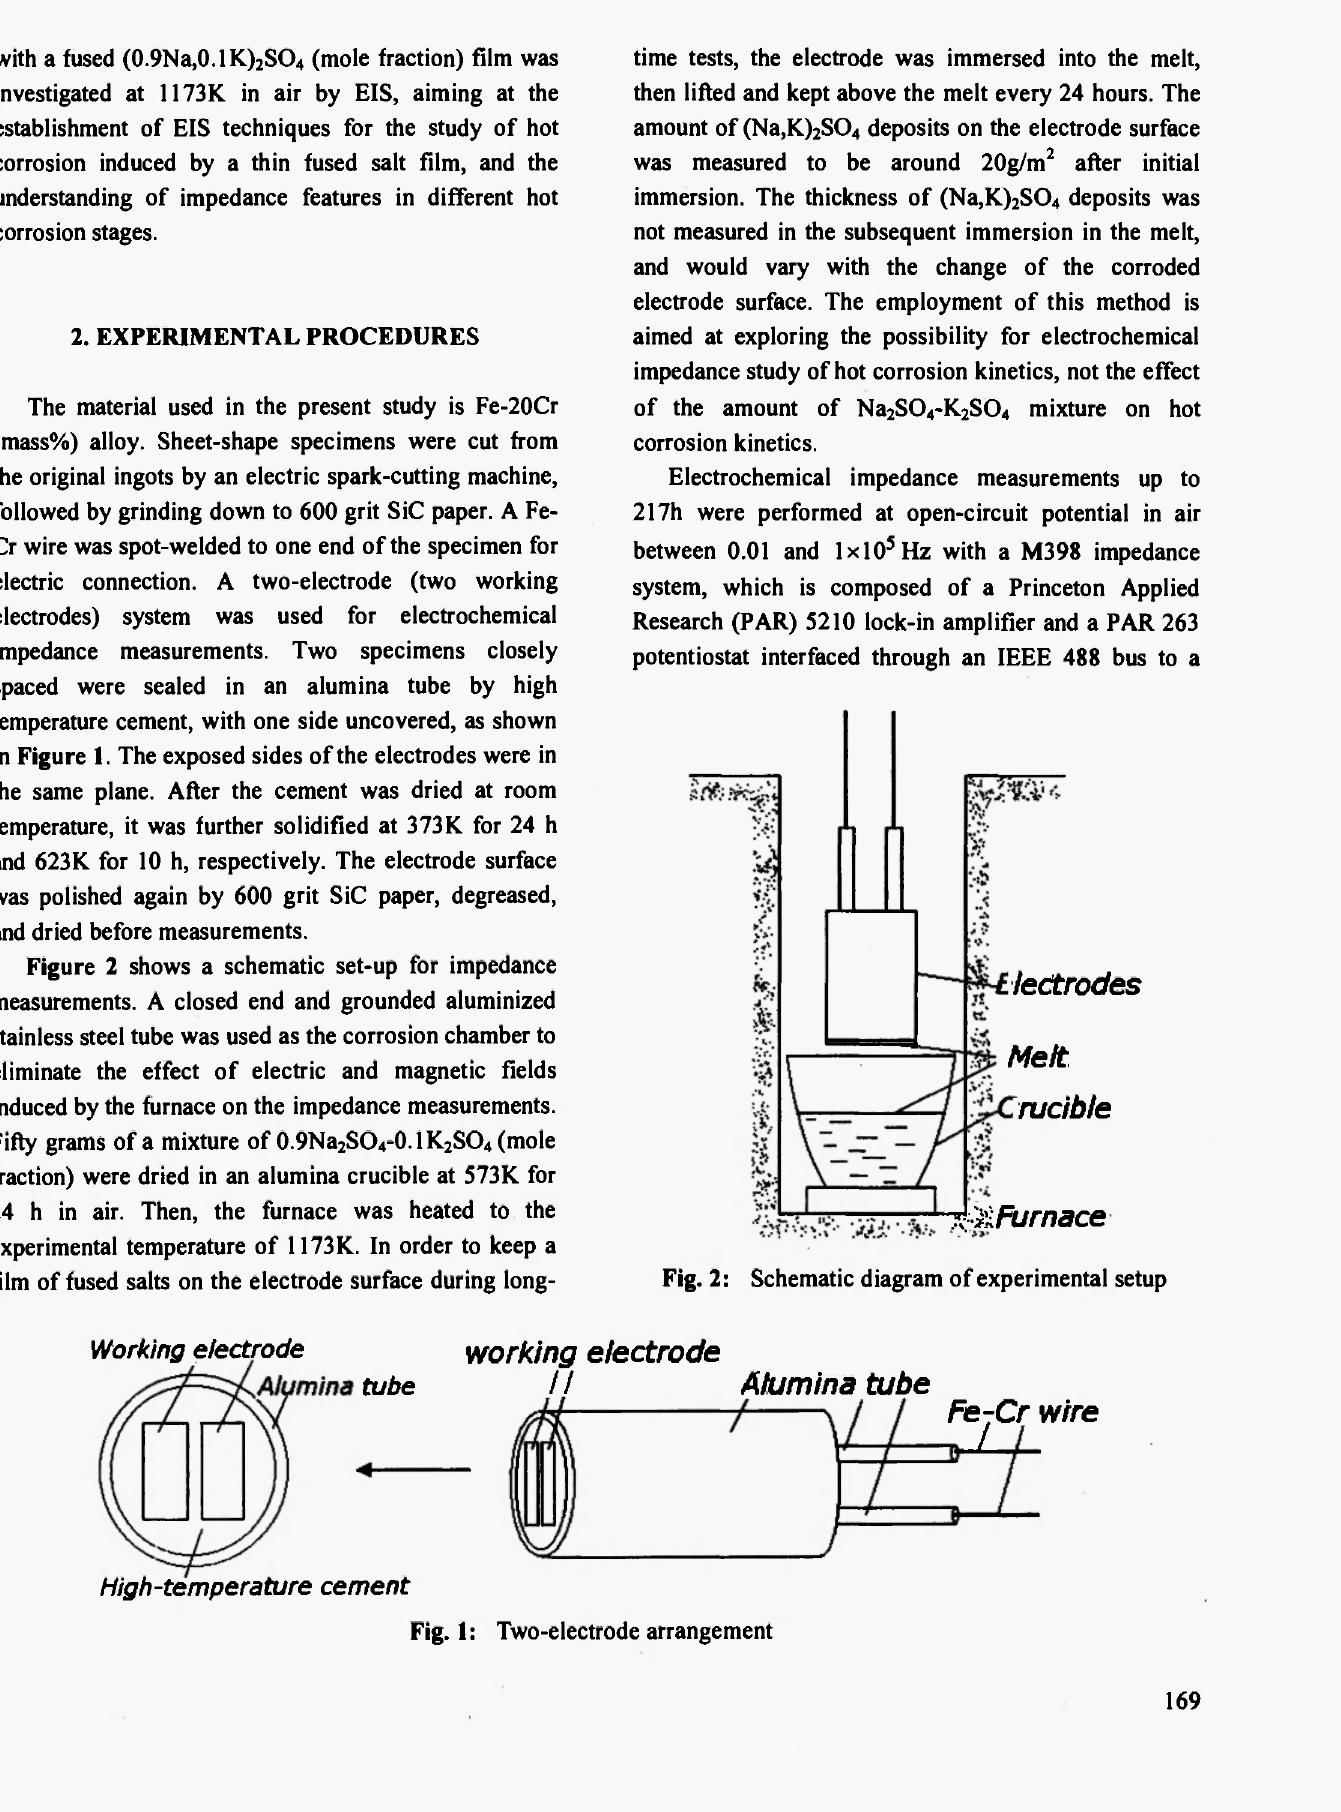
Fig. 1 : Two-electrode